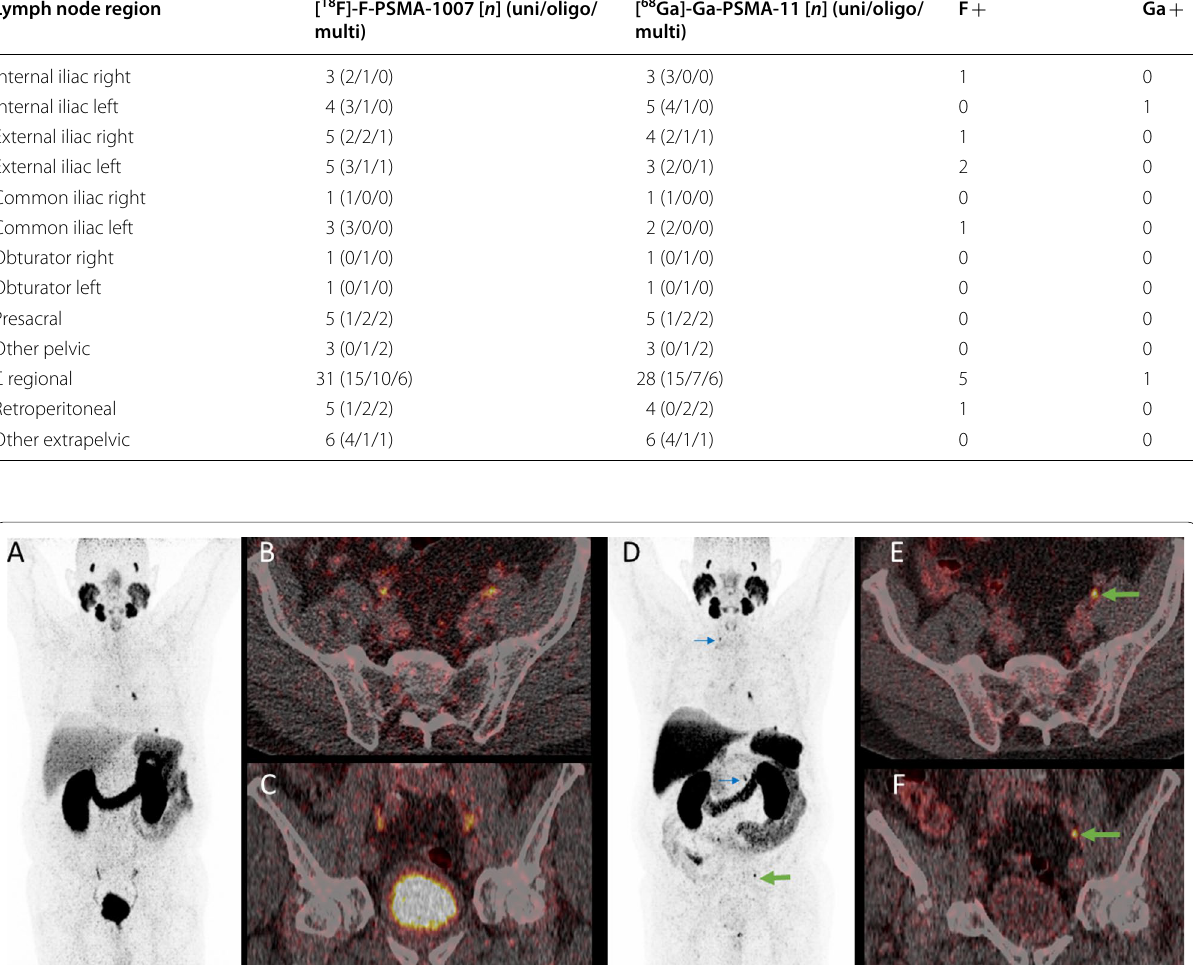
Fig. 6 MIP of [ 68 Ga]-Ga-PSMA-11 PET ( A ) with quite similar longitudinal uptake in both ureters. In both axial ( B ) and coronal fused ( C )